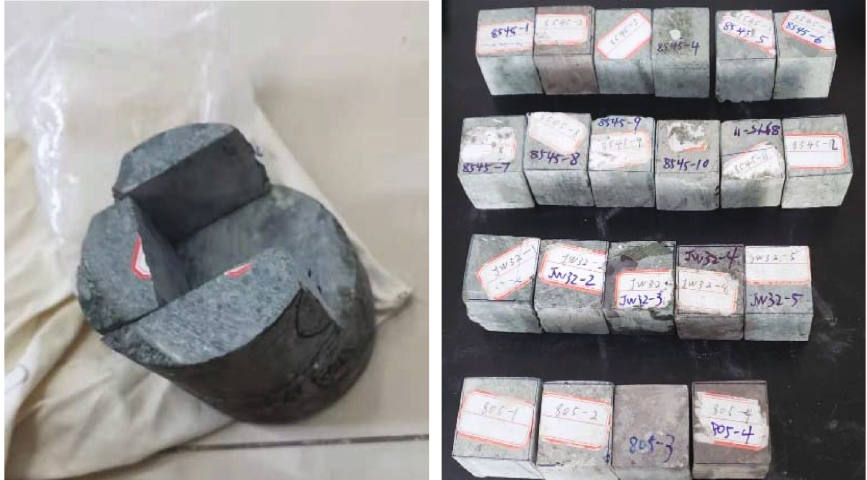
Figure 1: Photos of cubic cores before and after being drilled and cut on full-diameter rock samples.